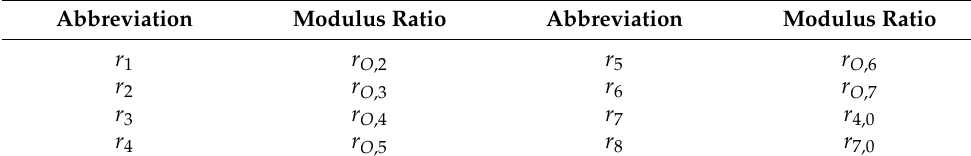
Table 4. Vector module ratio.